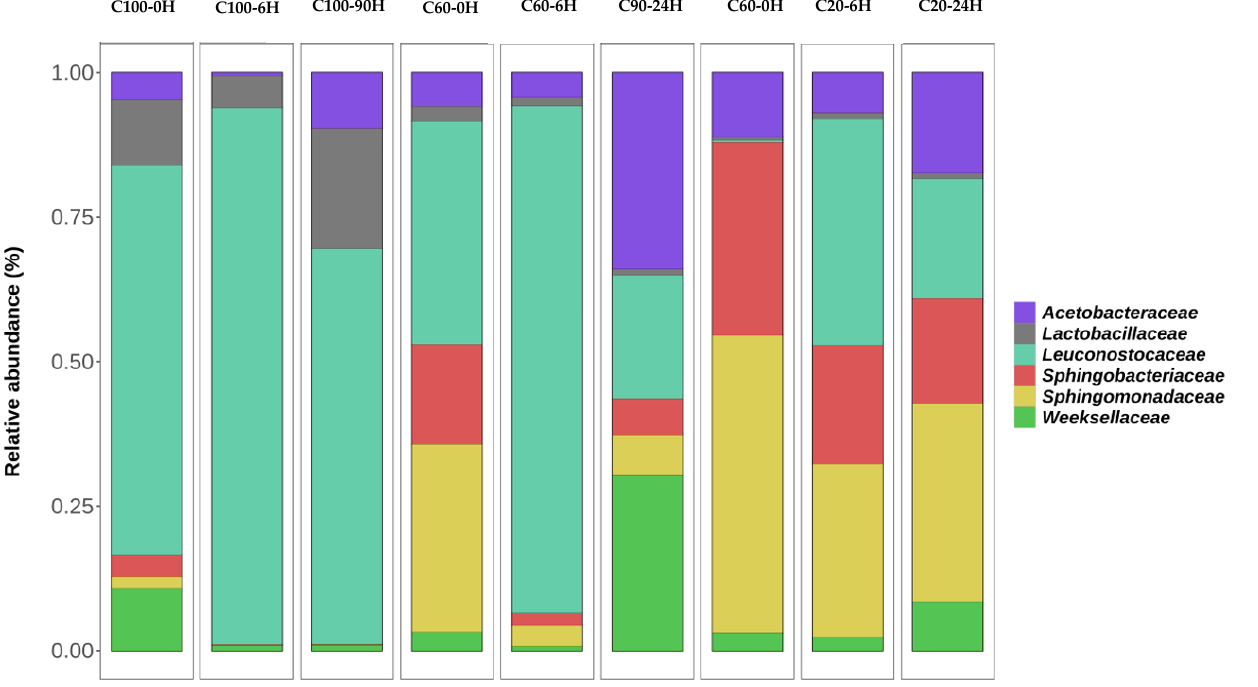
Figure 7. Relative abundance of the main bacterial families of cactus forage and buffel grass hay levels at different times of exposure to air. C100 = 100% cactus forage; C60 = 60% cactus forage and 40% buffel grass hay; C20= 20% cactus forage and 80% buffel grass hay; 0H = 0 h; 6H = 6 h and 24H = 24 h of exposure to air.